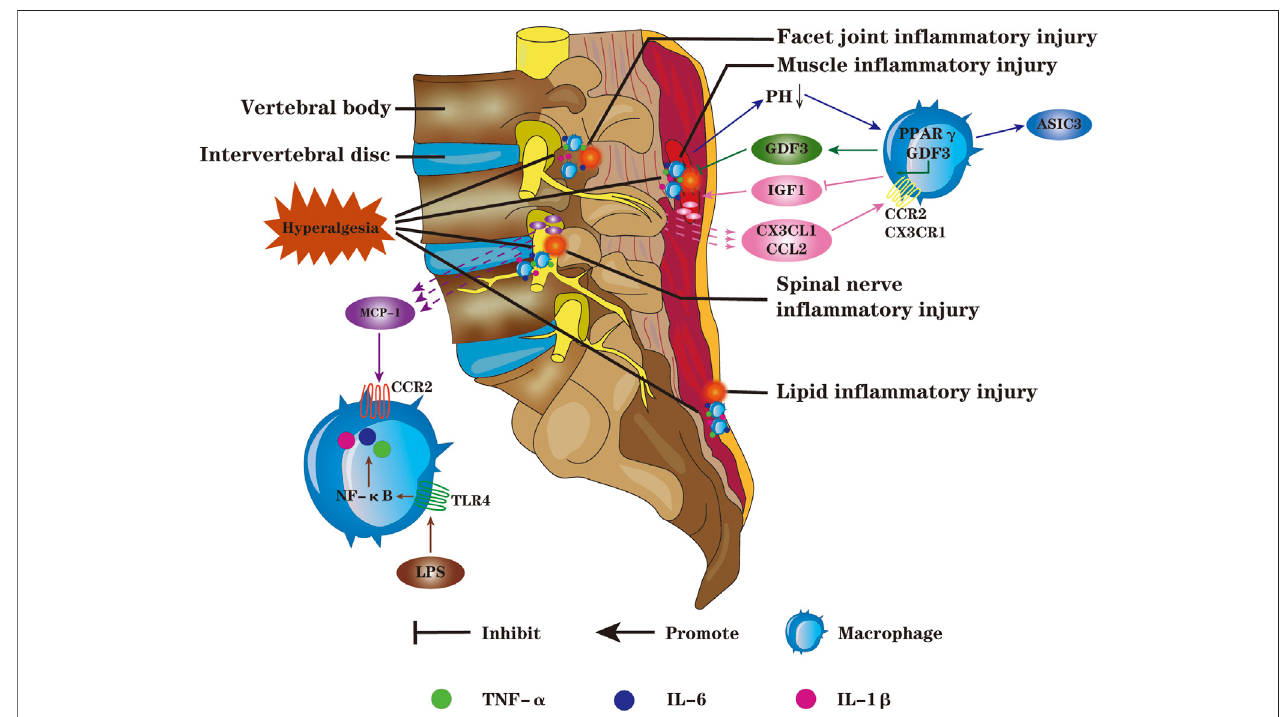
FIGURE3| Macrophagescan chemotaxis and migrate toadjacenttissues ofIVDsuch asparaspinalmuscles, DRG, facetjoints and fat; and then synthesize more pro-in fl ammatory factors such as TNF- α , IL-1 β and IL-6, resulting in spinal cord hyperalgesia, inducing or exacerbating LBP. The macrophages toward M1 polarization will lead to the accumulation of lactic acid in muscle, and the decrease of PH value can up-regulate the expression of ASIC3. Macrophages in fi ltrating into the damaged DRG promote the secretion of in fl ammatory mediators and induce neurogenic pain; macrophages can in fi ltrate the facet joints, aggravate the in fl ammation and degenerationofthefacetjoints,andcauseLBP.MacrophagesarethemainsourceofGDF3indamagedtissues,andPPARYinmacrophagescanpromotetissuerepair and regeneration by regulating the expression of GDF3. Chemokines CX3CL1 and CCL2 recruit macrophages and bind to CX3CR1 and CCR on macrophages,respectively, inhibiting the release of IGF1 and aggravating the in fl ammatory response; the chemokine MCP-1 could bind to CCR2, inducing and aggravating in fl ammation. The LPS acting on TLR4 in macrophages will lead to increased release of pro-in fl ammatory factors through the NF- K B signaling pathway.